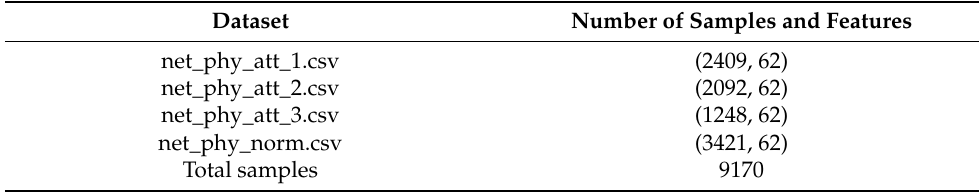
Figure 3. Additional network feature extraction and fusion architecture. Table 3. Cyber – physical dataset after feature fusion.